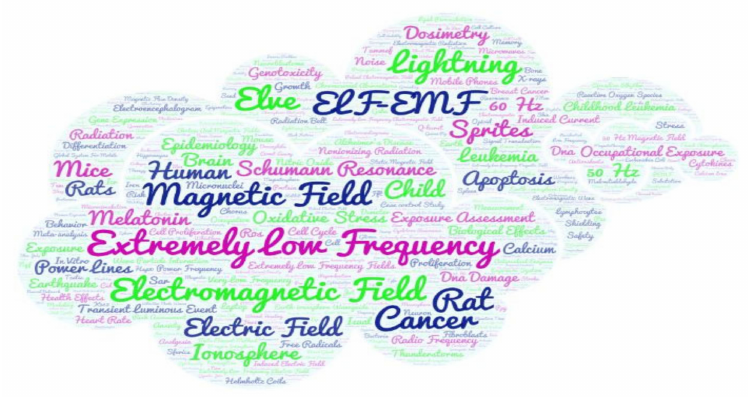
Figure 6. Representation of all global